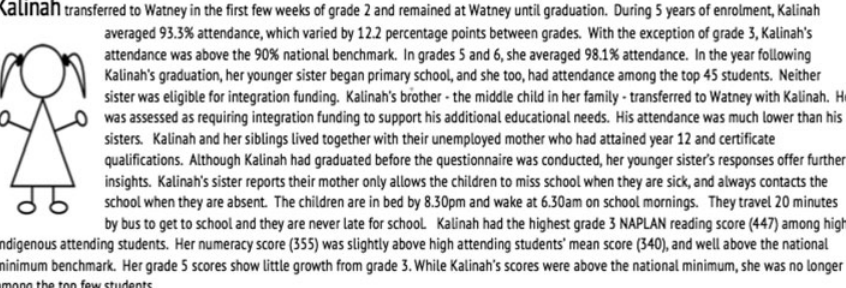
Fig. 3. Profile of Kalinah (pseudonym) that provides a holistic depiction of a high-attending student at Watney using data collected from the school ’ s admin- istrative records and questionnaire